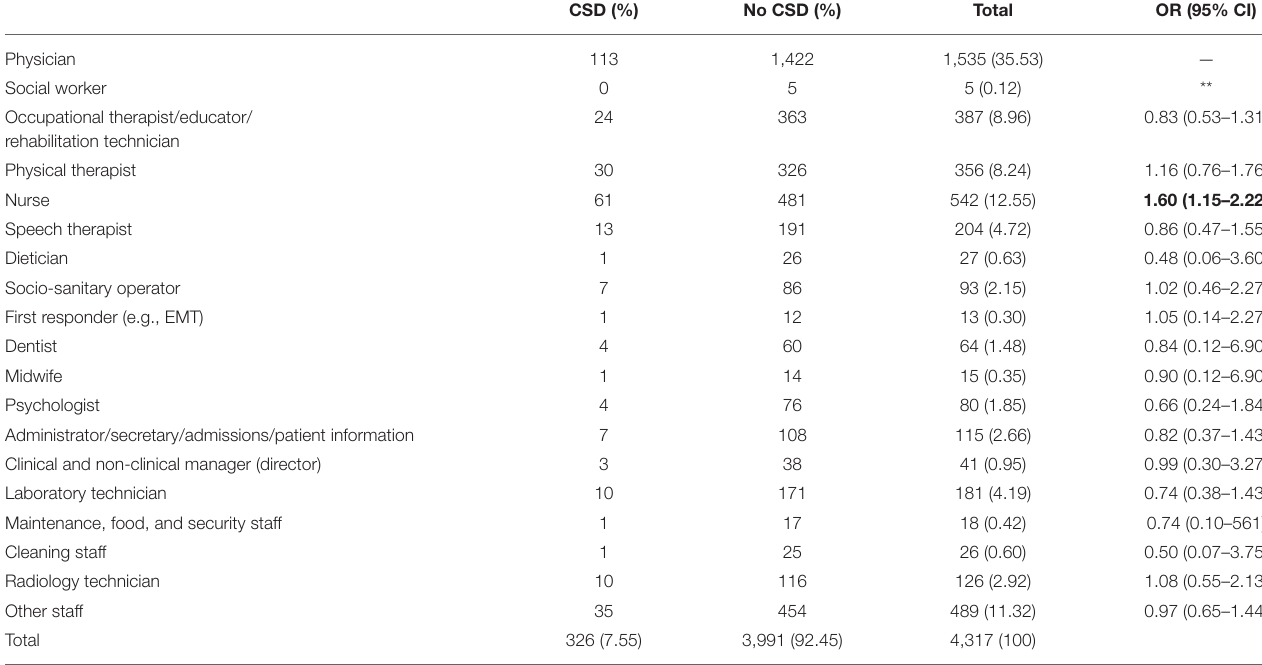
TABLE 4 | Characteristics of the respondents: CSD stratified by